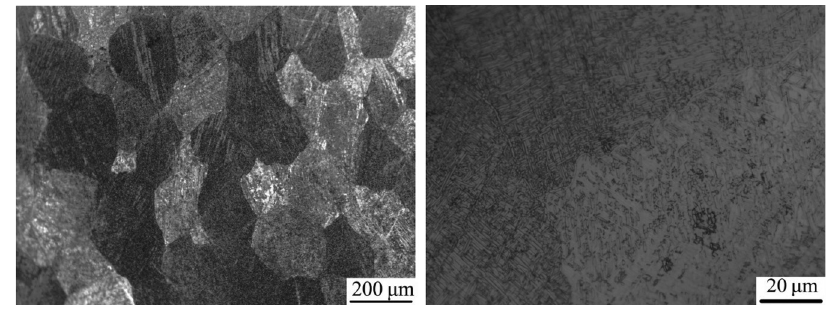
Figure 1 Initial microstructures of as-forged Ti-10V-2Fe-3Al